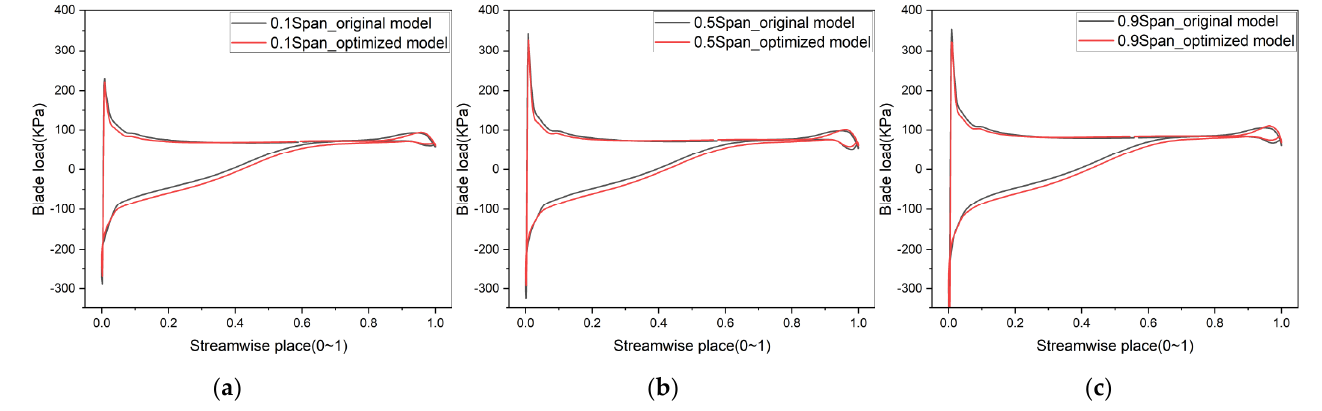
Figure 13. Distribution of blade loads along the span-wise place at 20%GVF condition. ( a ) 0.1 span, ( b ) 0.5 span, and ( c ) 0.9 span.